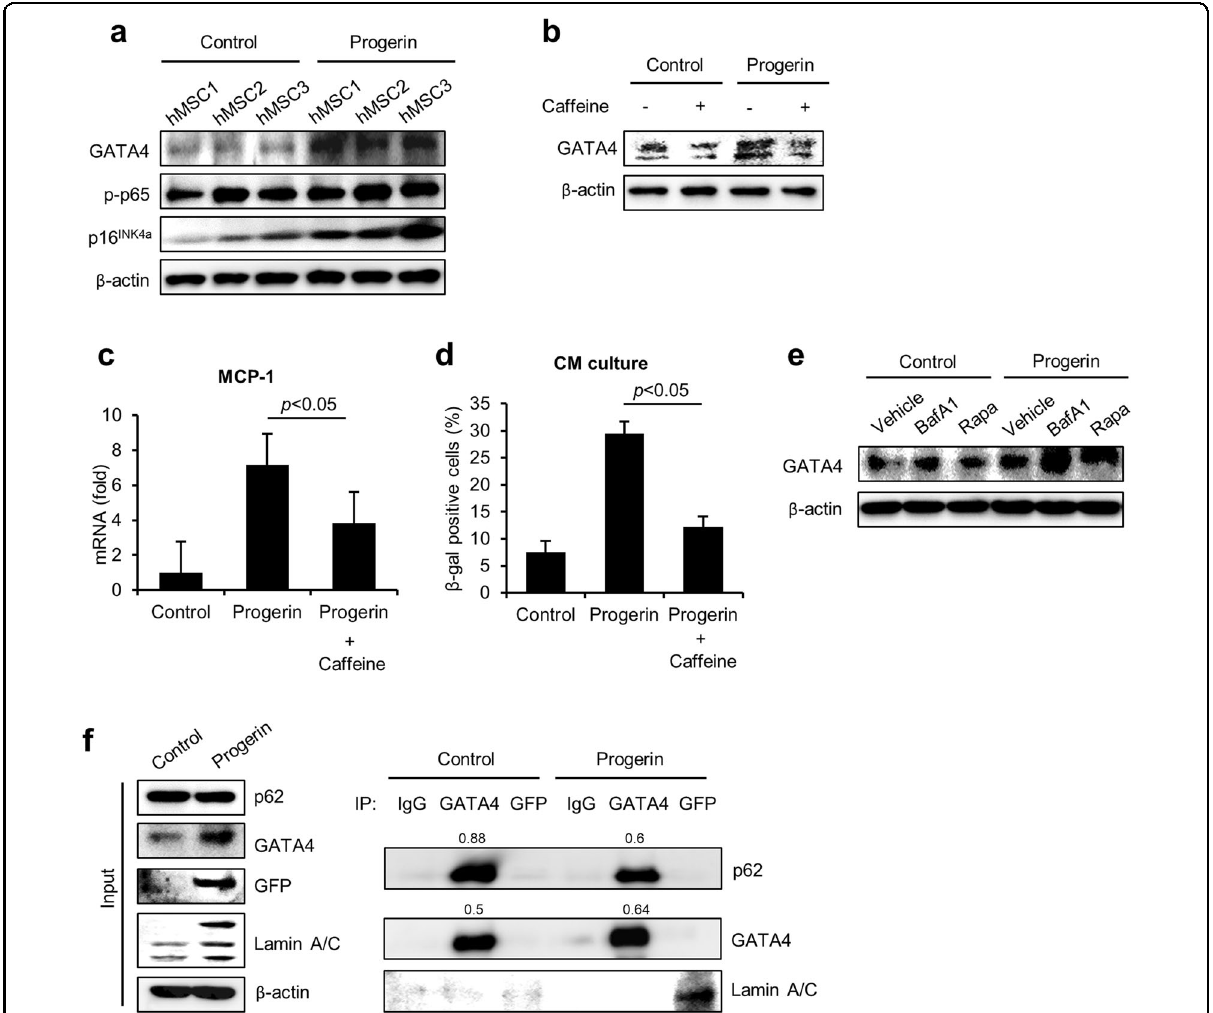
Fig. 3 GATA4 mediates the regulation of SASP induced by progerin. a After the introduction of GFP-progerin, GATA4 expression was detected using western blot analysis. b Western blot analysis of GATA4 was conducted in progerin-overexpressing MSCs after the treatment with caffeine (5 mM) for 2 h. c Quantitative PCR analysis of MCP-1 in progerin-overexpressing MSCs in the presence of caffeine (5 mM) for 2 h. d hMSCs were cultured with CM from control or progerin-expressing hMSCs in the presence of caffeine. After 4 days of CM culture, the indicated cells were fi xed and stained for the SA- β -gal activity. e Control and progerin-overexpressing hMSCs were treated with ba fi lomycin A1 (200 nM) or rapamycin (0.68 μ M) for 7 h. The abundance of GATA4 protein was analyzed by western blotting. f Immunoblotting of GATA4 and GFP immunoprecipitates from control or progerin- expressing hMSCs. hMSCs were treated with ba fi lomycin A1 for 7 h before sampling to block GATA4 degradation. Error bars represent means ± s.d. from three separate experiments. Student ’ s t -test was used for the statistical